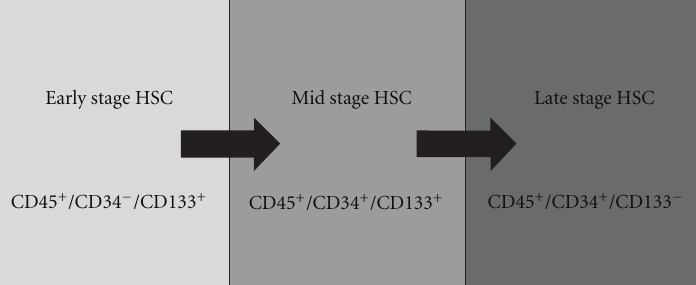
Figure 1: Subtyping of HSCs. HSC di ff erentiation has a specific pattern from early to mid to late stages defined by surface antigen expression.